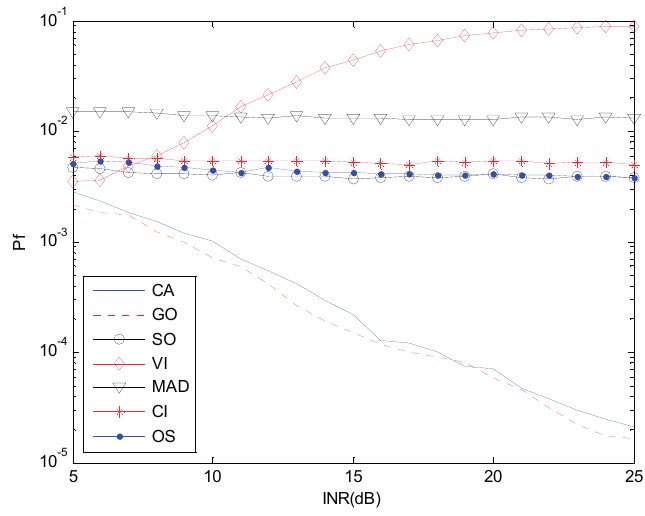
Figure 13. P vs . INR in the non-homogenous environment, r(0,2). f